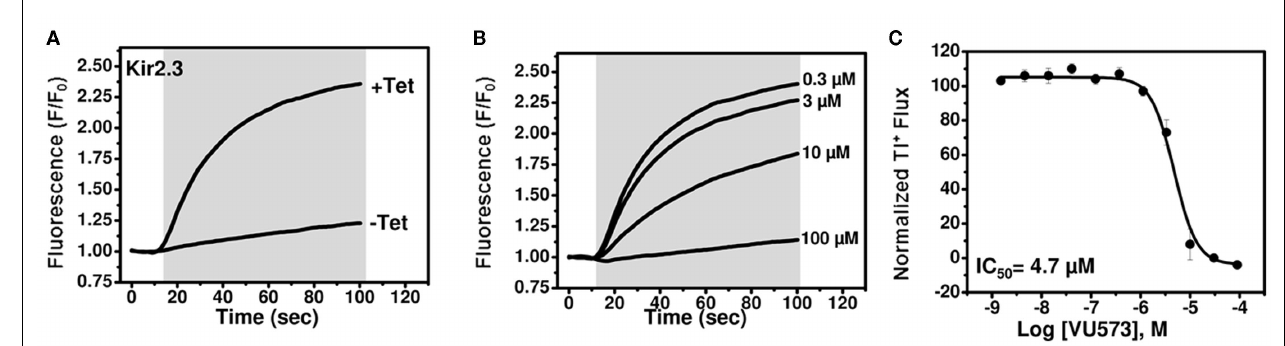
FIGURE 4 | Development of a thallium flux assay for Kir2.3. (A) Thallium flux-dependent FluoZin-2 fluorescence recorded from monoclonal Kir2.3 T-REx-HEK-293 cells cultured overnight in absence ( − Tet) or presence ( + Tet) of Tetracycline.The fluorescence emission was recorded before and after the addition of extracellular thallium (shaded box). (B) Representative traces for